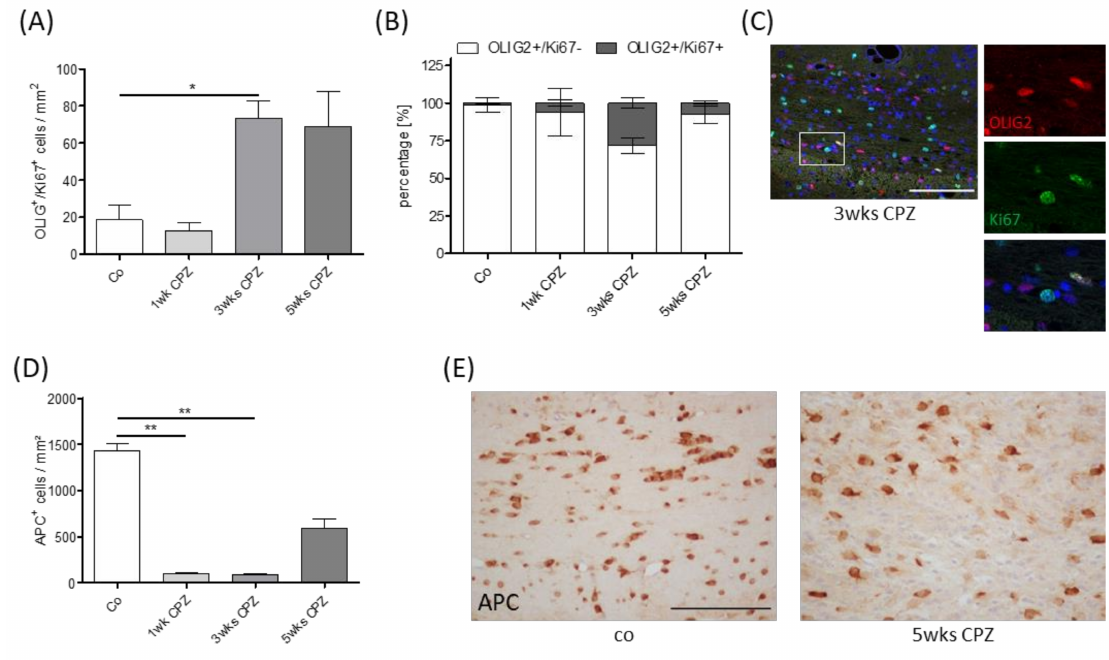
Figure 2. Oligodendrocyte pathology. ( A ) Quantity of OLIG2 + and Ki67 + single and double positive cells during the course of cuprizone-induced demyelination (Kruskal–Wallis test followed by Dunn’s multiple comparison test). ( B ) Percentage of single and double positive cells in relation to the entire OLIG2 + cell population. ( C ) Representative image of OLIG2 + and Ki67 + double positive cells. ( D ) Quantification of APC + cell numbers (Kruskal-Wallis test followed by Dunn’s multiple comparison test). ( E ) Representative images of anti-APC stained sections in the medial corpus callosum. Scale bar: 100 µ m. The following symbols were used to indicate the level of significance: * p < 0.05, ** p <